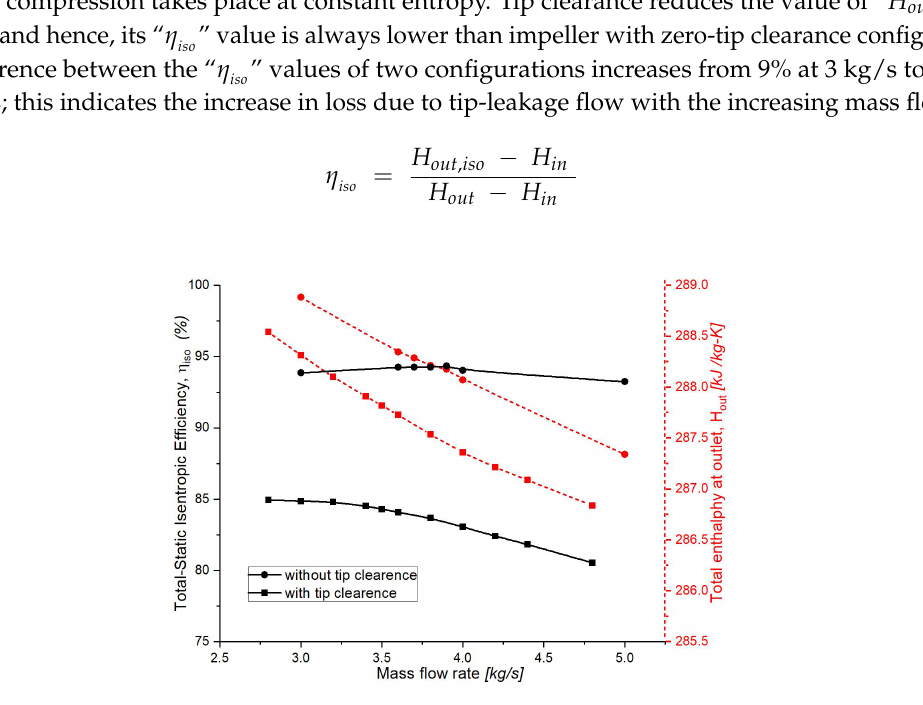
Figure 7. The isentropic compression efficiency and the total enthalpy at outlet for the impeller without and with tip clearance configurations. Solid lines indicate the total-static isentropic efficiency and the dashed lines shows the total enthalpy at the